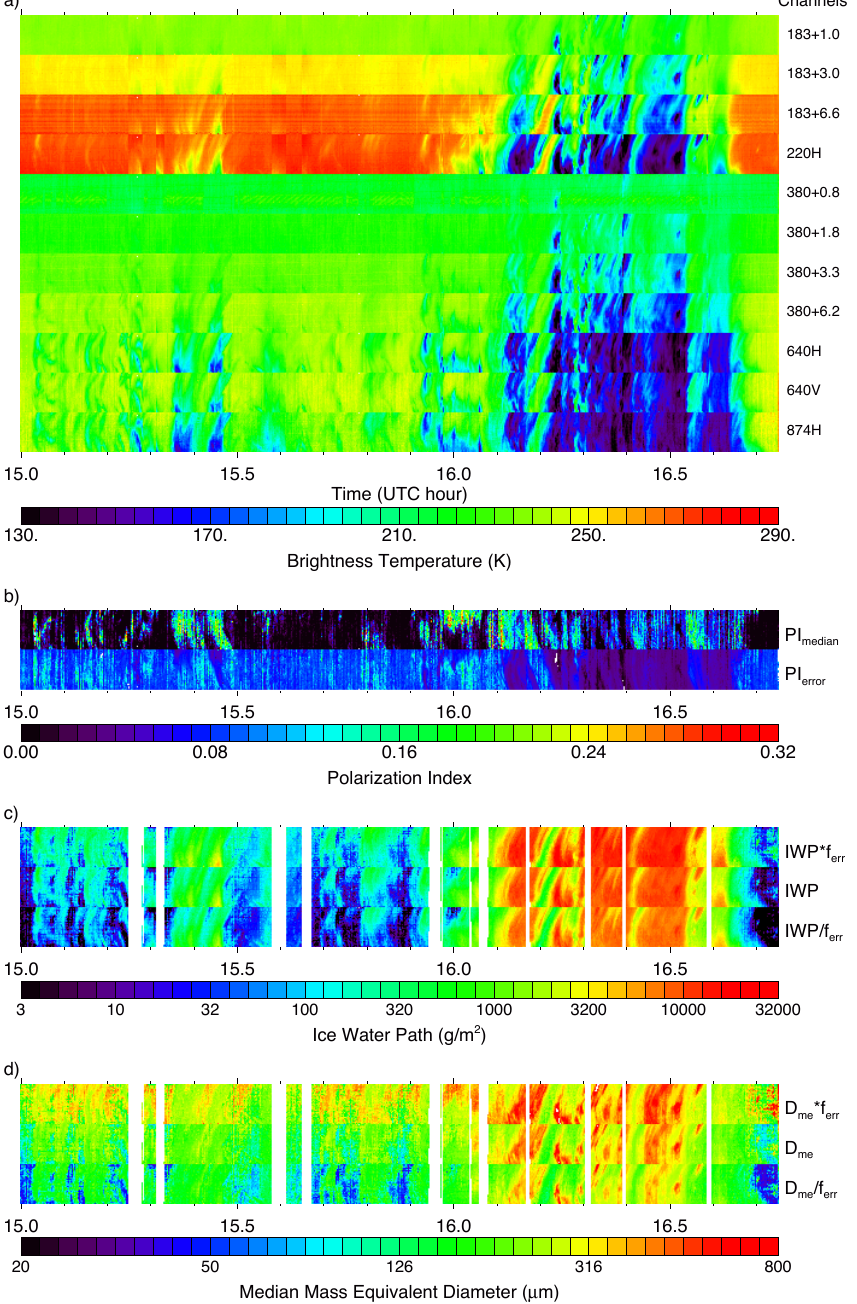
Fig. 7. CoSSIR forward conical scan swath images from 17 July 2007 showing (a) brightness temperatures for the 11 channels, (b) retrieved 640GHz polarization index (median and RMS error), (c) retrieved ice water path, and (d) retrieved median mass diameter. The retrieved error range for IWP and Dme are shown using the error factor, ferr, which is the exponential of the RMS error of ln(IWP) or ln(Dme). Retrievals are not performed during turns of the ER-2 aircraft, leaving the white vertical